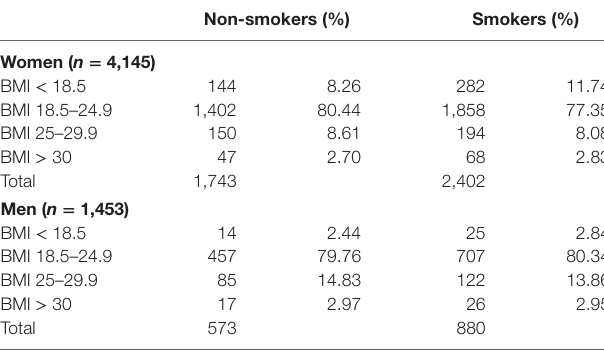
TaBle 2 | Distribution of patients across BMI categories for smokers and non-smokers.